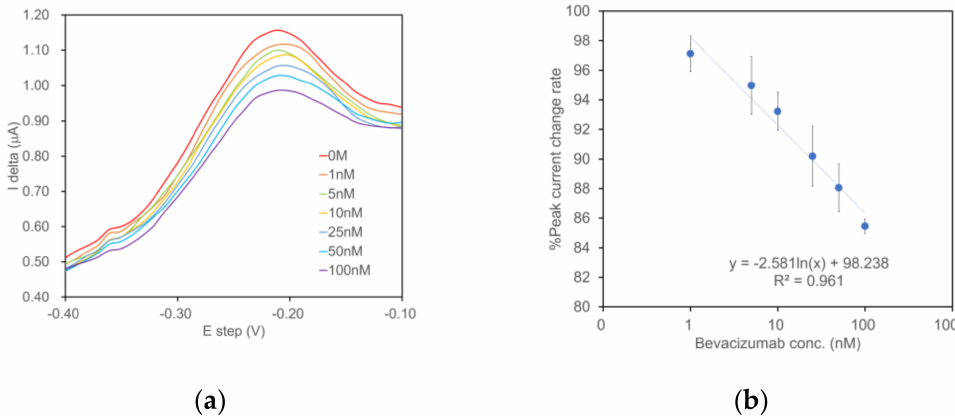
Figure 2. ( a ) Square-wave voltammogram of PES-bivalent A14#1 aptamer immobilized sensor at 100 Hz in PBS solution. SWV scans were conducted as the following conditions: − 0.4 to − 0.1 V, 25 mV amplitude. Seven concentrations of bevacizumab were used: 0 nM (the base line in the absence of bevacizumab),1, 5, 10, 25, 50, and 100 nM. ( b ) Concentration-response curve; the % of signal change calculated as 0M = 0%. The error bars indicate the standard deviations ( N =